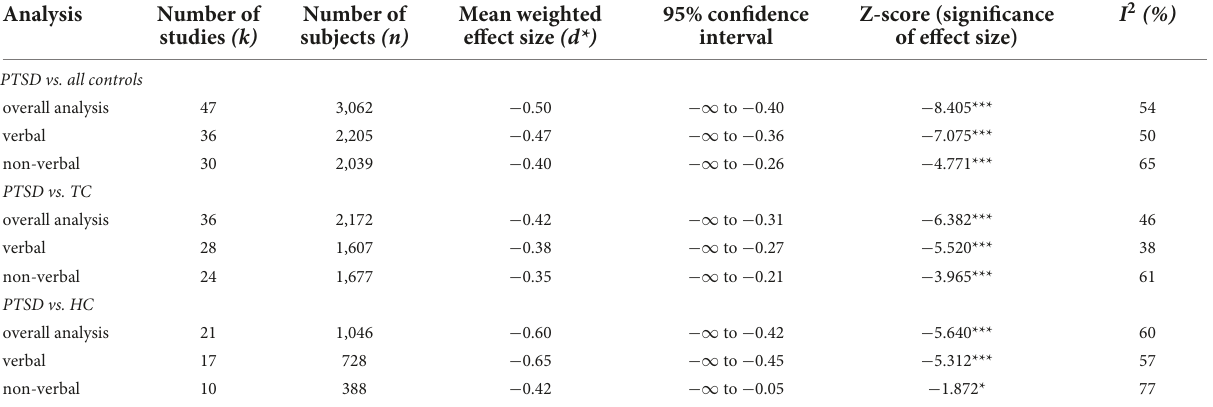
TABLE 2 Results of random-effects meta-analyses by control group and stimulus material.